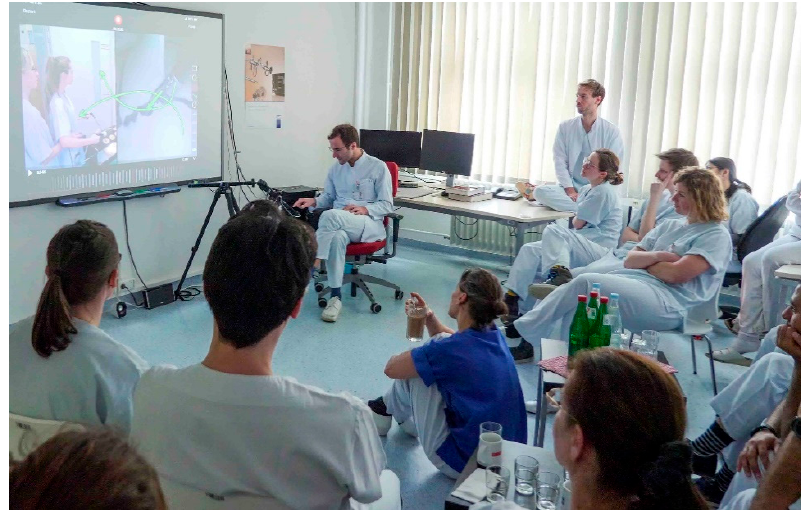
Figure 3. Setting of the video feedback assessment.